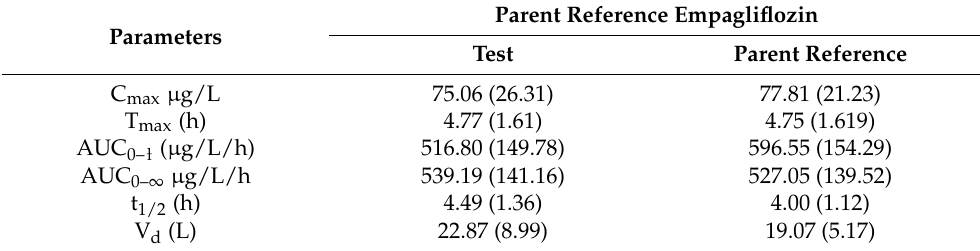
Table 1. Empagliflozin pharmacokinetic parameters after a single 10 mg in two cases; male volunteers ( n = 26). Data are mean (SD).